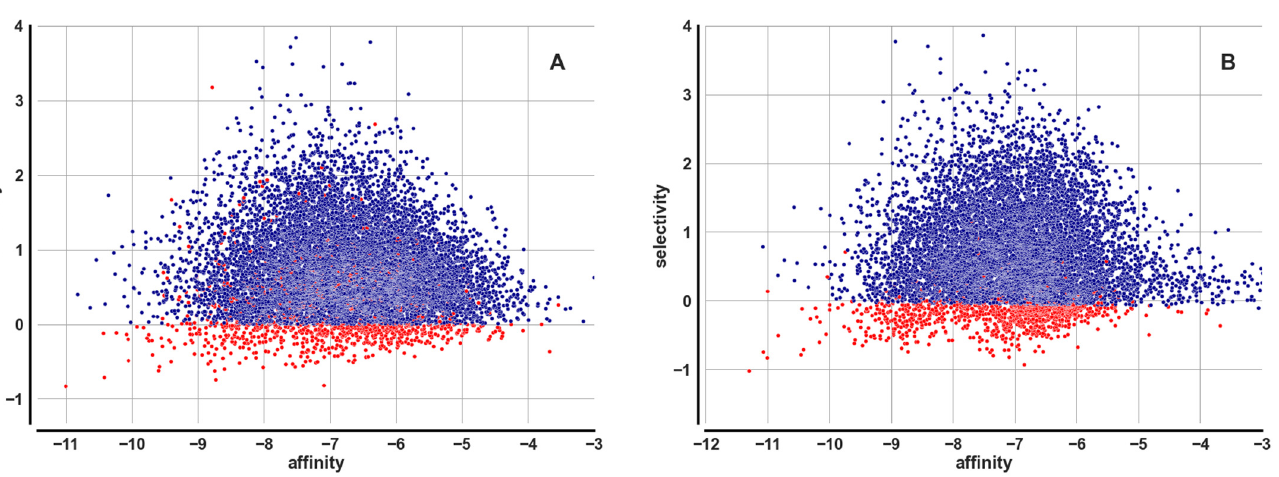
Figure 6. Affinity vs. selectivity, scatterplot. ( A ) before the similarity search. ( B ) after the similarity search.